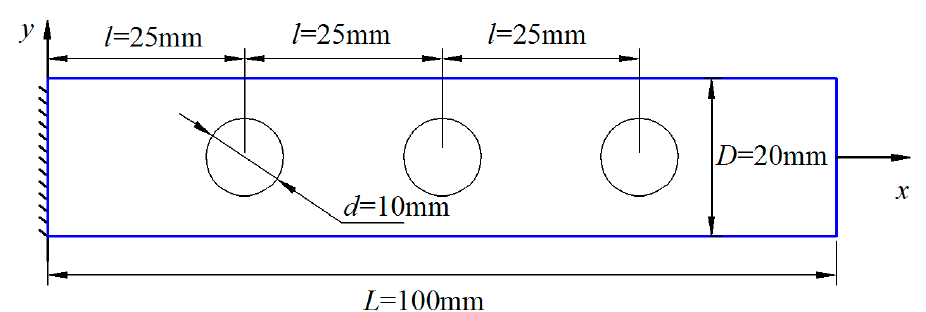
Figure 10. The cantilever beam with three identical holes and in plane stress condition.